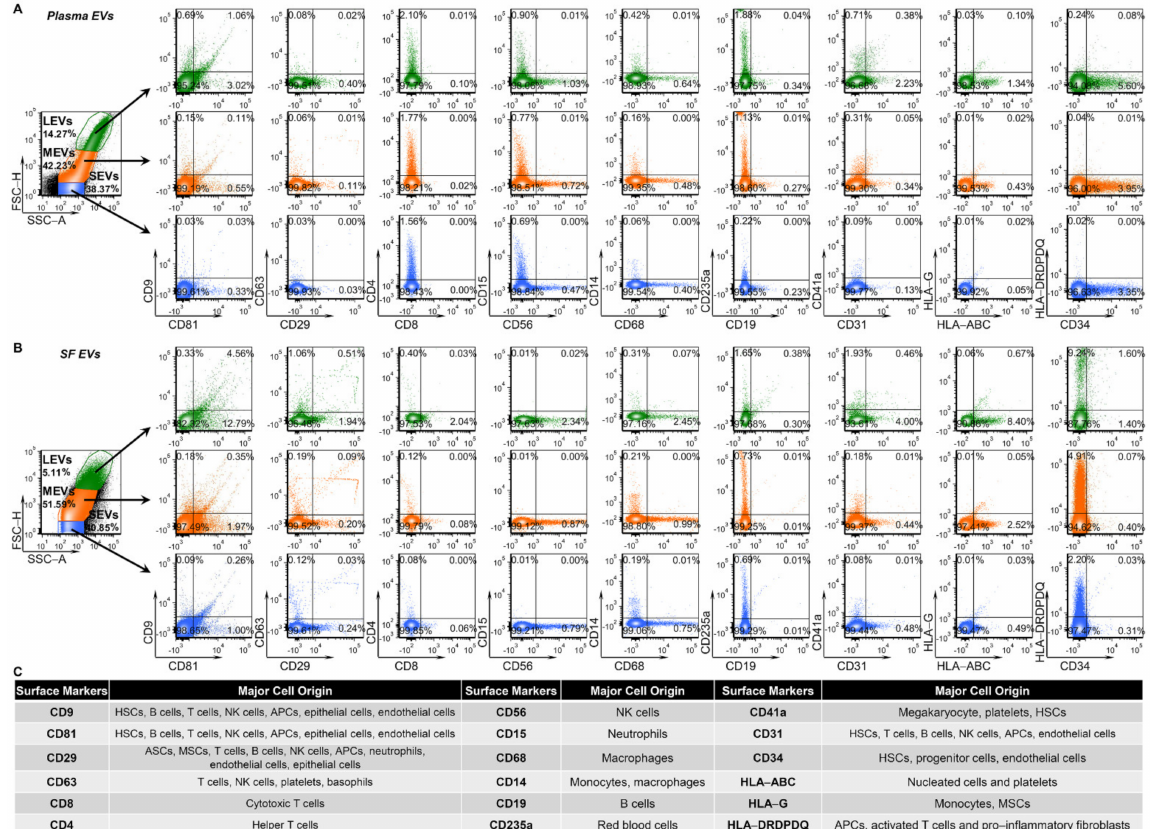
Figure 1. Plasma and SF EVs from OA participants carry surface markers from the major hematopoietic cell subsets indicating their cell origins. EVs from plasma and SF of OA participants were profiled with the indicated surface markers by high-resolution multicolor flow cytometry. ( A , B ) The graphs present the representative color dot plots of all tested surface markers in gated large (LEVs), medium (MEVs) and small (SEVs) EVs from the matched plasma ( A ) and SF ( B ) of one OA participant. ( C ) The table summarizes the tested surface markers and their major expressing cells in human. HSCs: hematopoietic stem cells; ASCs: adipose stem cells; MSCs, mesenchymal stem cells; NK cells: natural killer cells; APCs: antigen presenting cells (including monocytes, macrophages and dendritic cells); HLA-ABC: HLA-A, HLA-B and HLA-C; HLA-DRDPDQ: HLA-DR, -DP and